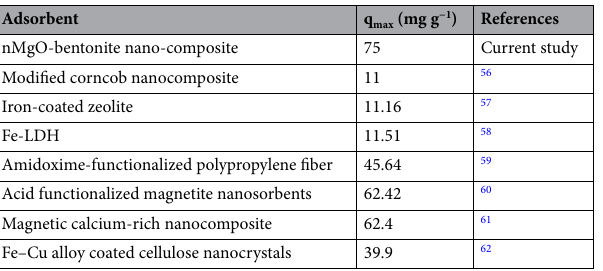
Table 4. Maximum adsorption capacities (q max ) of Pb(II) adsorption onto nanocomposite and various adsorbents documented in the